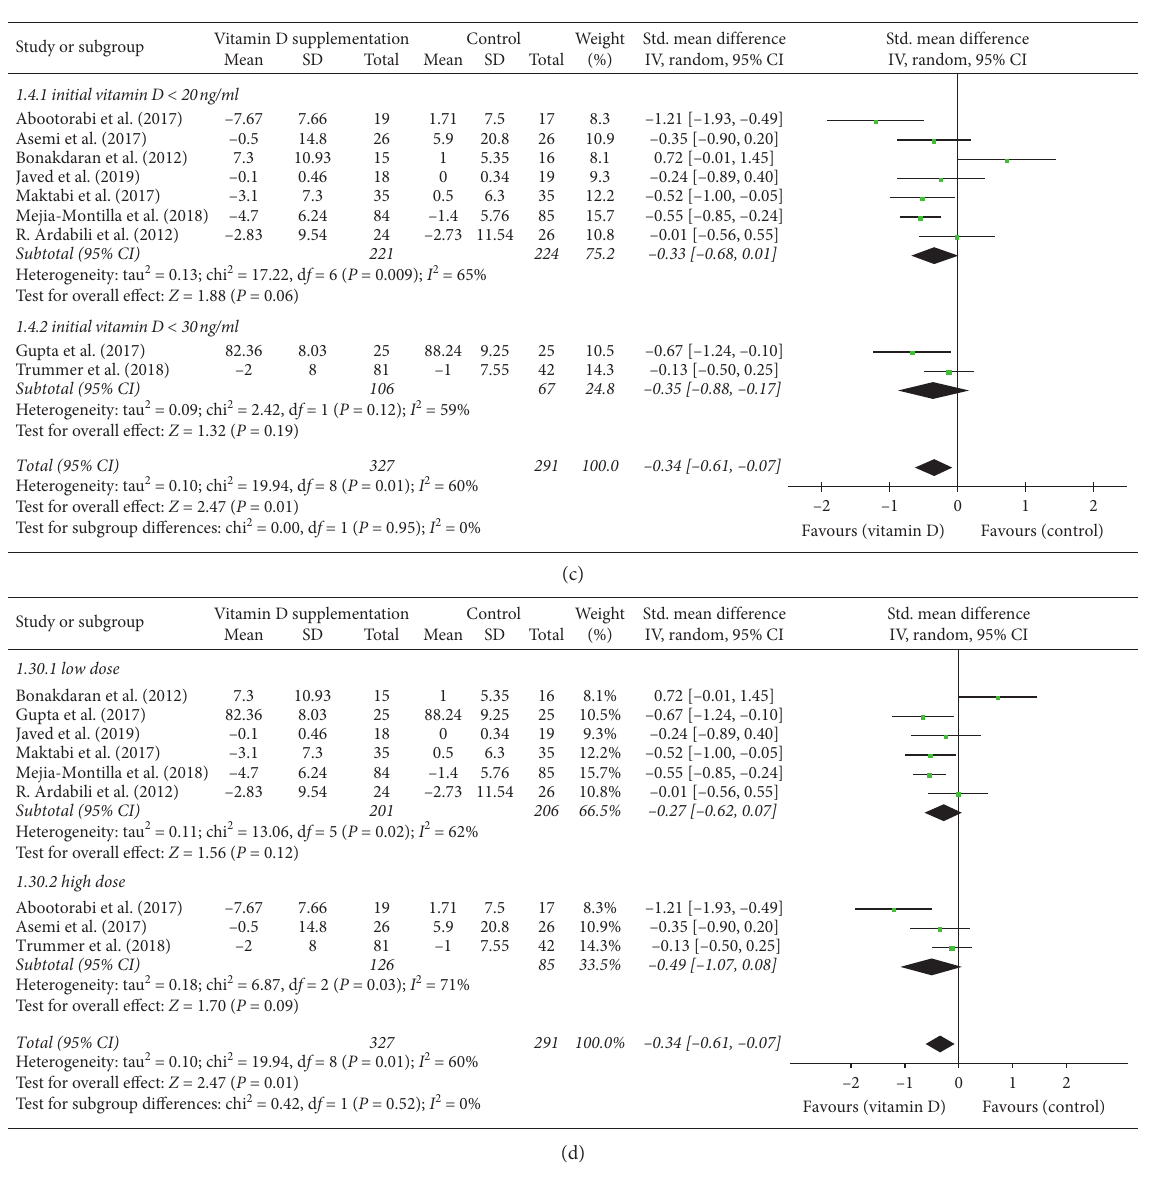
Figure 4: (a) Forest plot of FPG level in experimental and placebo groups. (b) Forest plot of FPG level in women with PCOS supplemented by day, week, and 20 days. (c) Forest plot of FPG level in women with PCOS who have vitamin D deficiency or insufficiency. (d) Forest plot of FPG level in women with PCOS supplemented with low- or high-dose vitamin